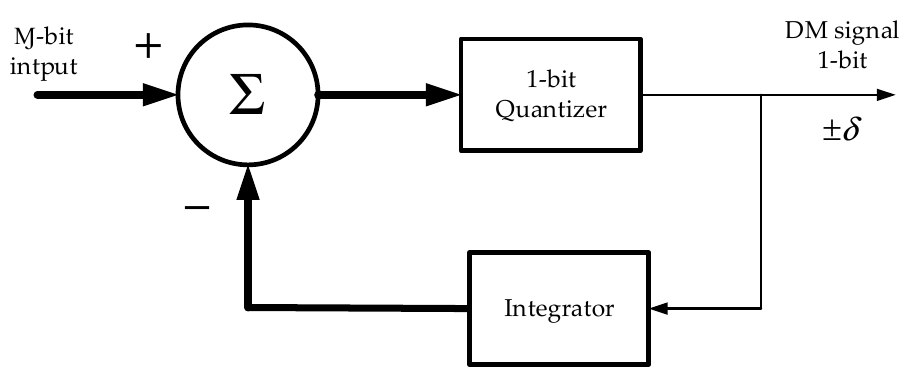
Figure 4. Block diagram of the DM modulator of Figure 2a.